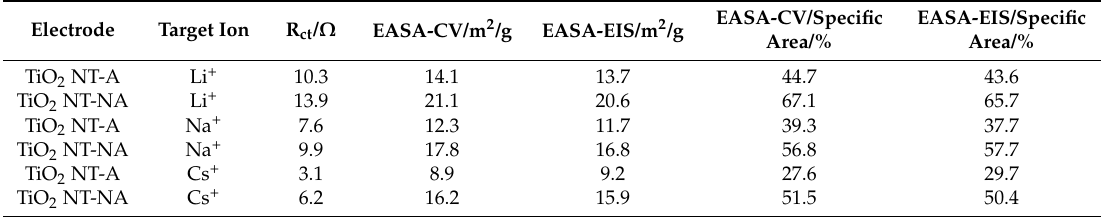
Table 1. Electrochemically-active surface area (EASA) for TiO 2 NT-A and TiO 2 NT-NA determined via CV and